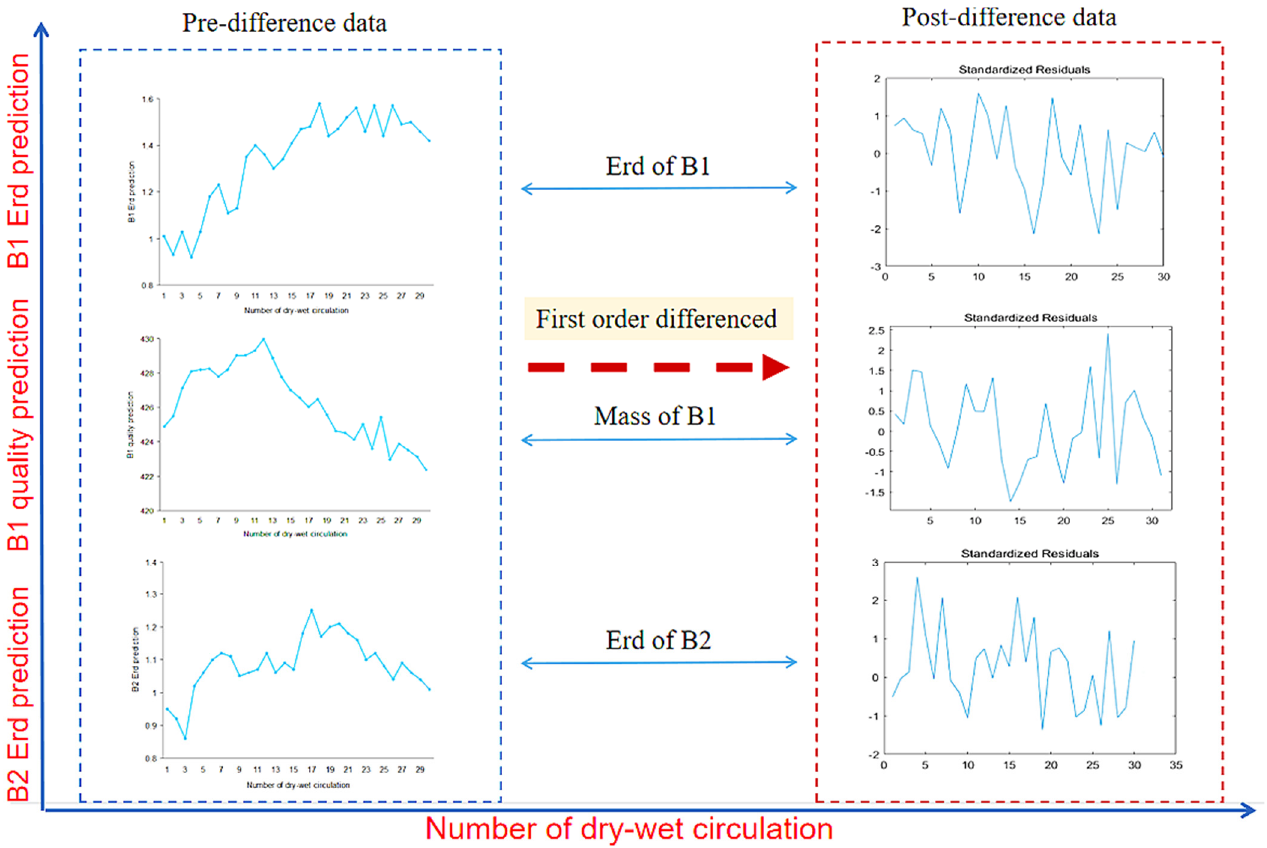
Figure 7. First-order difference of the ARIMA model.